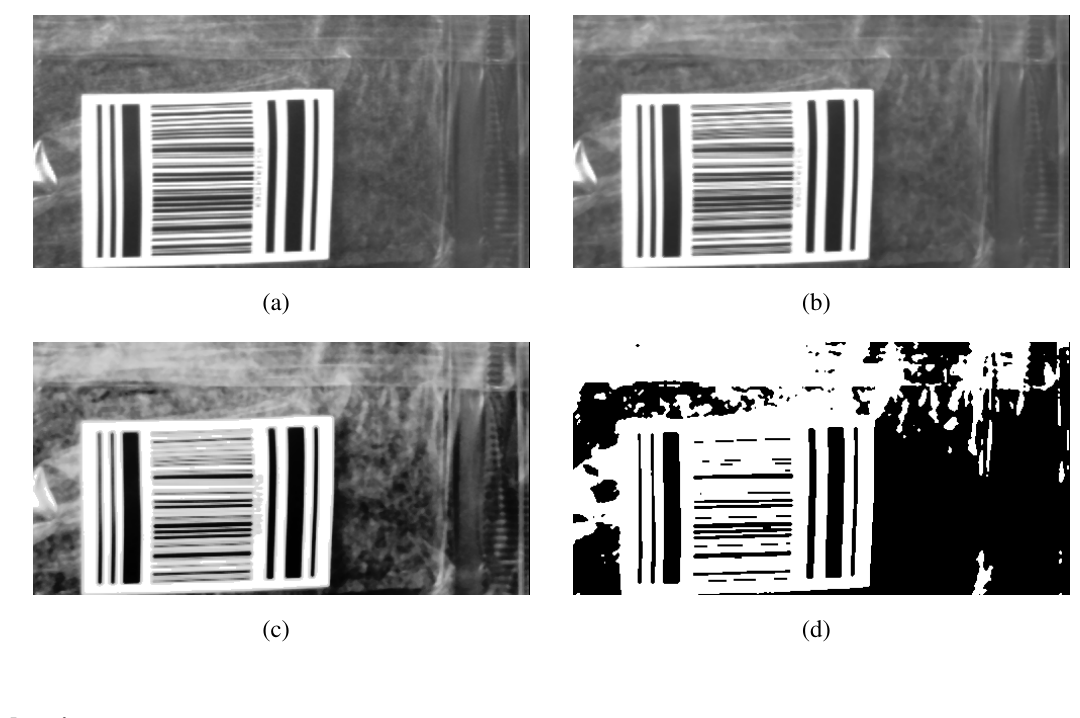
Figure 17. Image states in template matching based marker detection: ( a ) grayscale image, ( b ) filtered grayscale image, ( c ) histogram equalized grayscale image and ( d ) binary